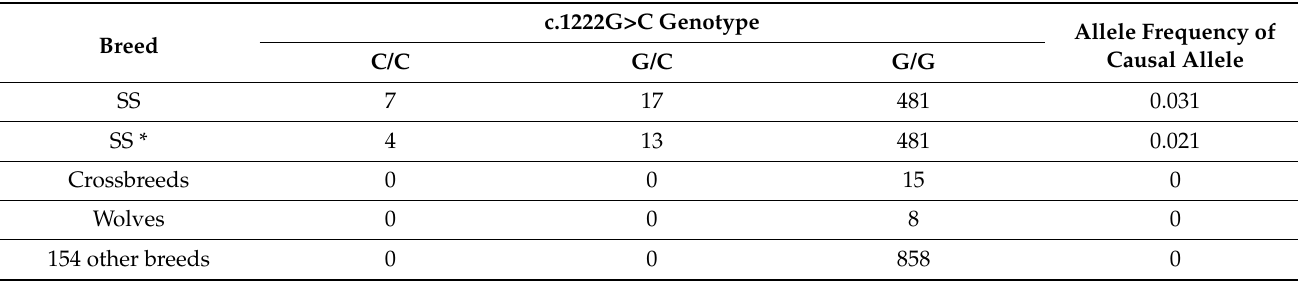
Table 3. Allele frequency of BBS2 c.1222G>C SNV in multiple breeds of dog. ‘G’ represents the wild-type/common allele, ‘C’ represents the alternate allele.